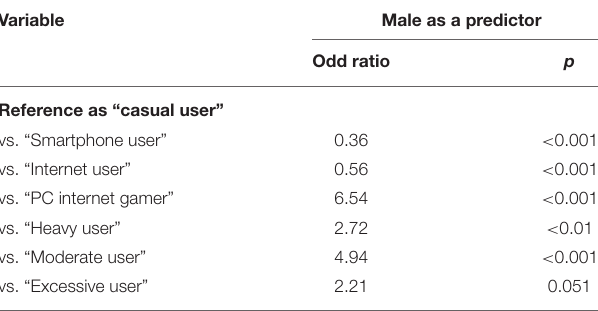
TABLE 5 | Male as a predictor of Internet and Internet game usage profile. Variable